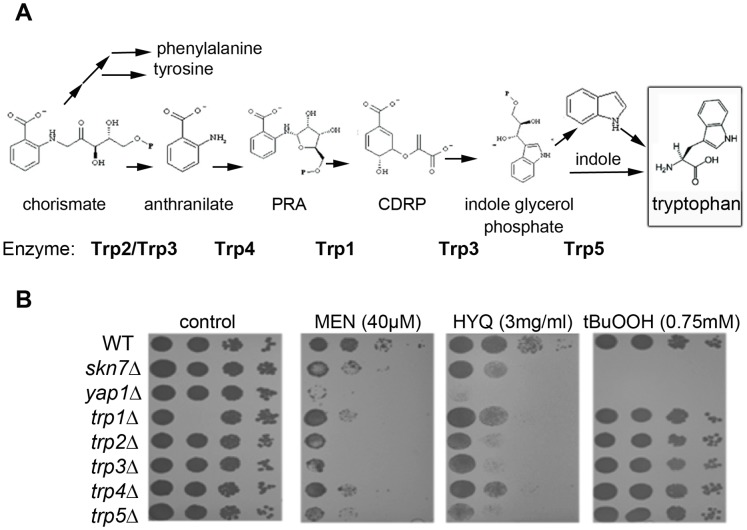
Tryptophan biosynthesis rescues cells from ROS.A) A schematic of the tryptophan biosynthesis pathway [29]. PRA: N-(5′-phospohribosyl)-anthsranilate, CDRP: 1-(o-carboxyphenylamino)-1-desoxyribuose-5-phosphate. B) Compound sensitivity of selected mutant strains were analyzed by spot assay. Strains were grown in liquid YPD+G418 overnight at 30°C and then diluted in YPD. Ten-fold serial dilutions of each yeast culture was spotted onto YPD plates in the absence (control) and presence of the different compounds: MMS (0.006%), MEN (40 µM), HYQ (3 mg ml−1), and tBuOOH (0.75 mM). Plates were incubated at 30°C and growth was recorded after 48 h exposure.